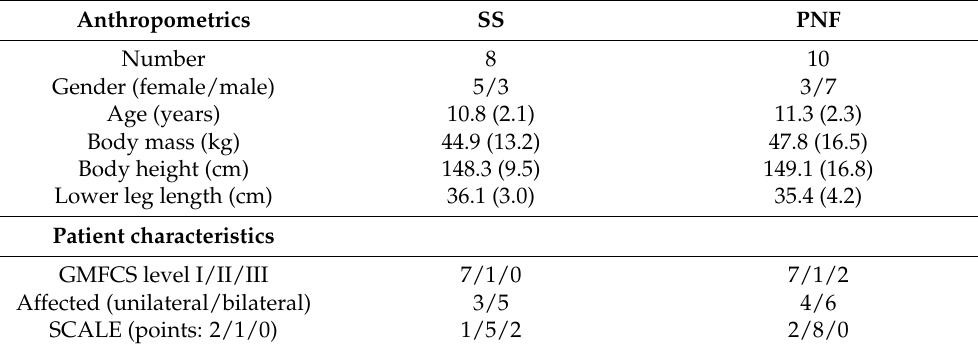
Table 1. Participant characteristics of the children with spastic cerebral palsy in the static stretching (SS) and proprioceptive neuromuscular facilitation (PNF) groups. Data are presented as mean (SD). Anthropometrics